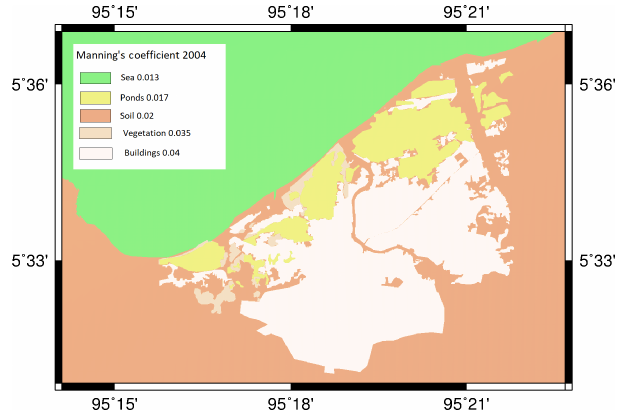
Table 3. Manning’s coefficients based on land cover of the area (Li et al., 2012).